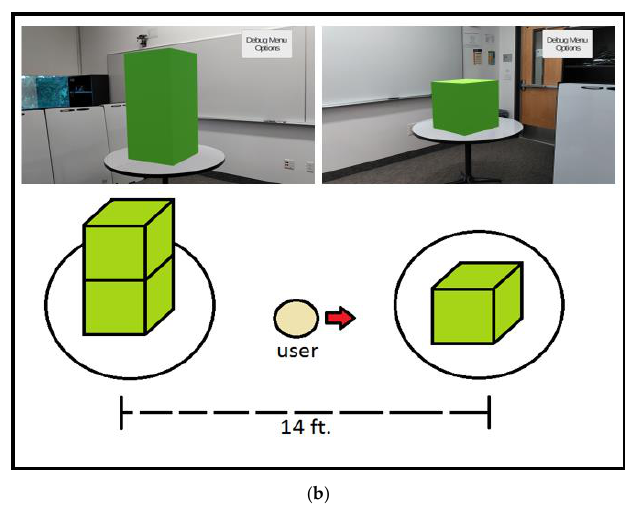
Figure 4. Large-scale object manipulation. ( a ) Test 4: translation; ( b ) Test 5: object placement.